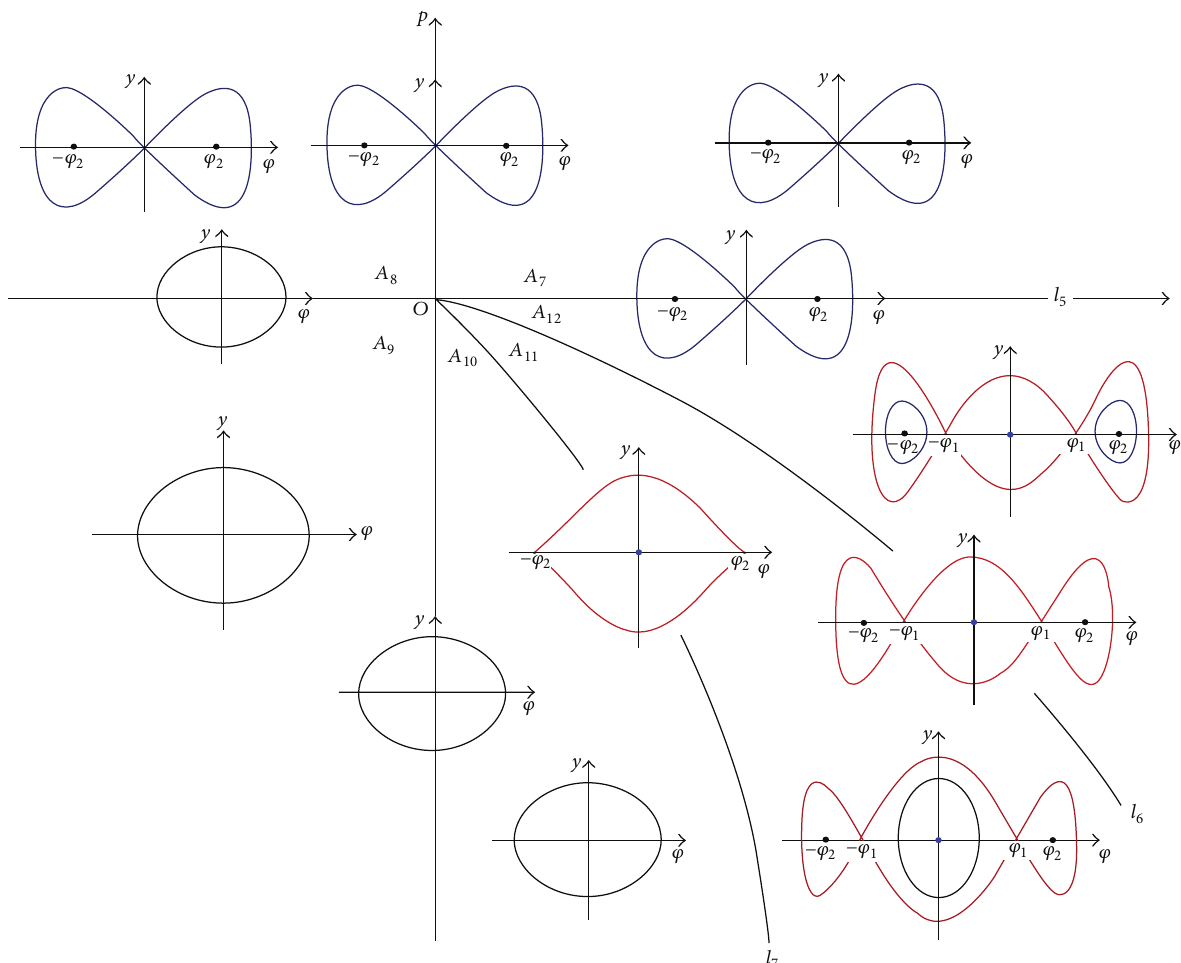
Figure 16: The bifurcation phase portraits of system (54) for 𝑟 < 0